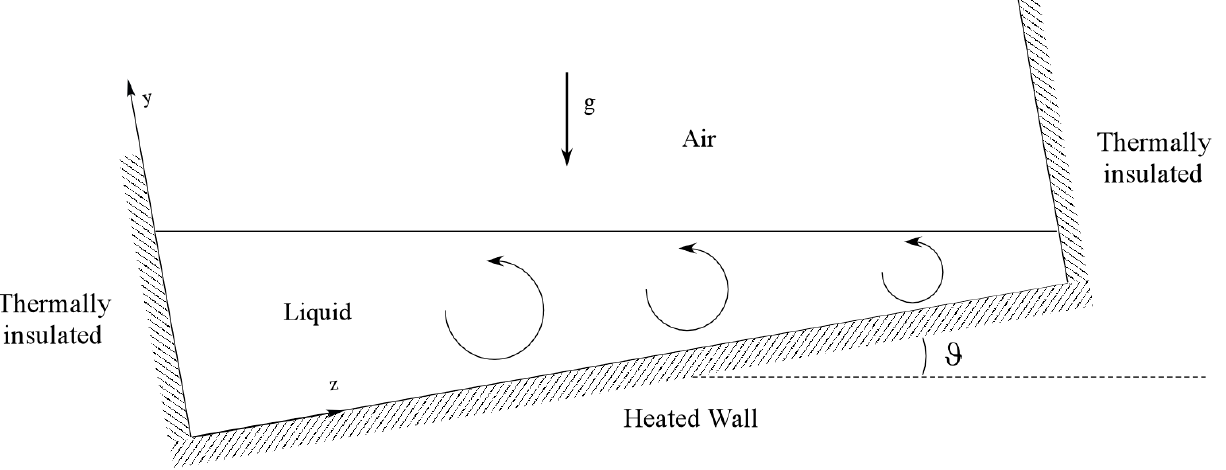
Figure 1. Sketch of the considered